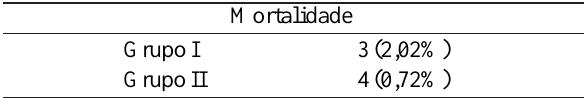
Tabela 5. Mortalidade comparada nos grupos I e II não evidenciou significância